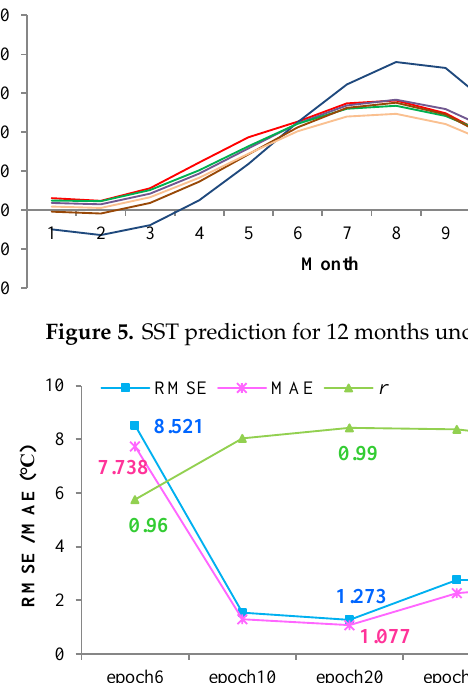
Figure 6. Prediction accuracy for 12 months under different epochs. RMSE: root mean square error; MAE: mean absolute error.